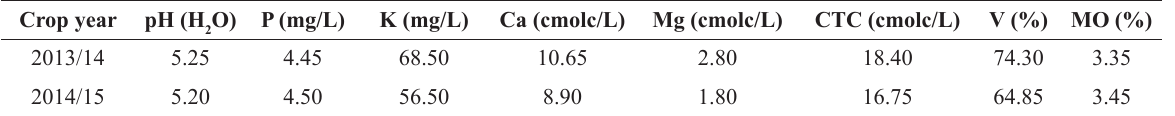
Physical-chemical composition of the experimental area in the different crop years (2013/2014 and 2014/2015). Southern,